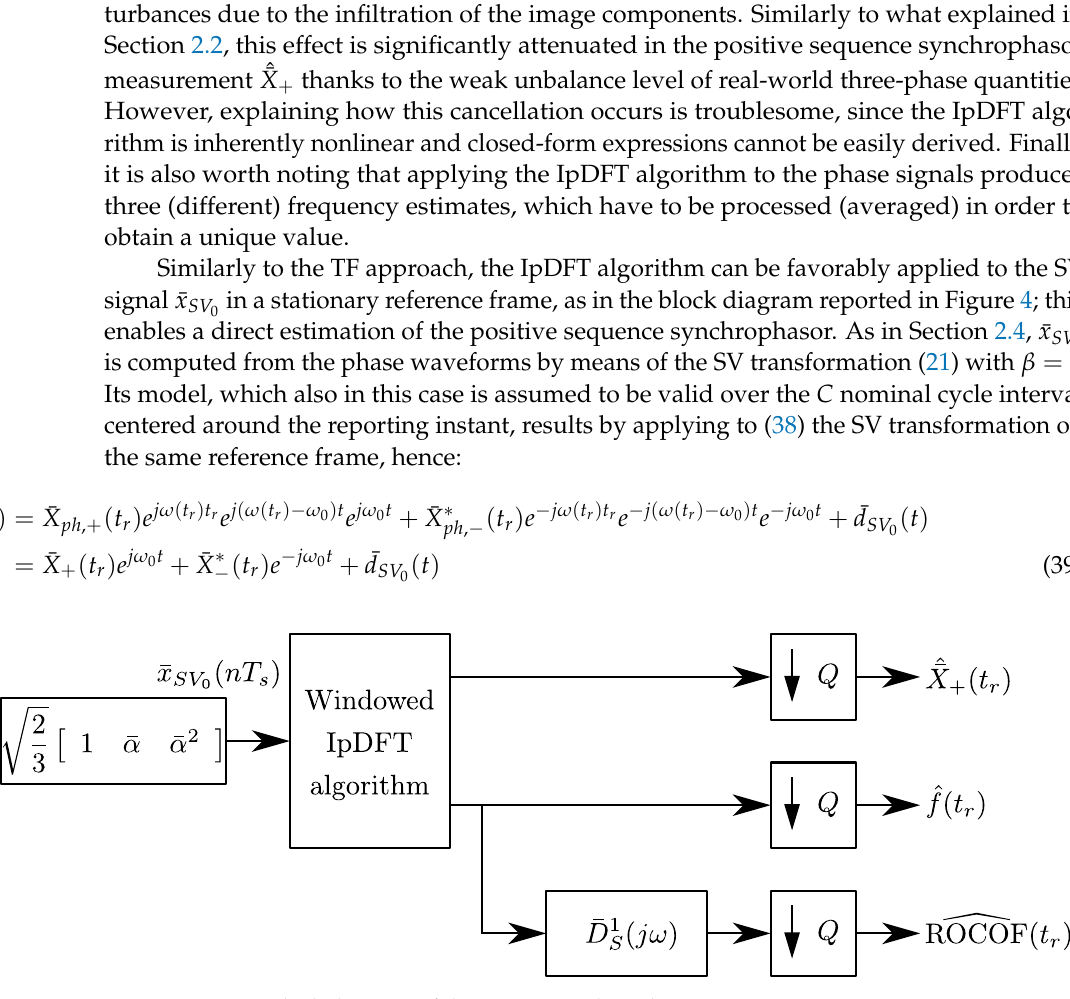
Figure 4. Block diagram of the SV-IpDFT